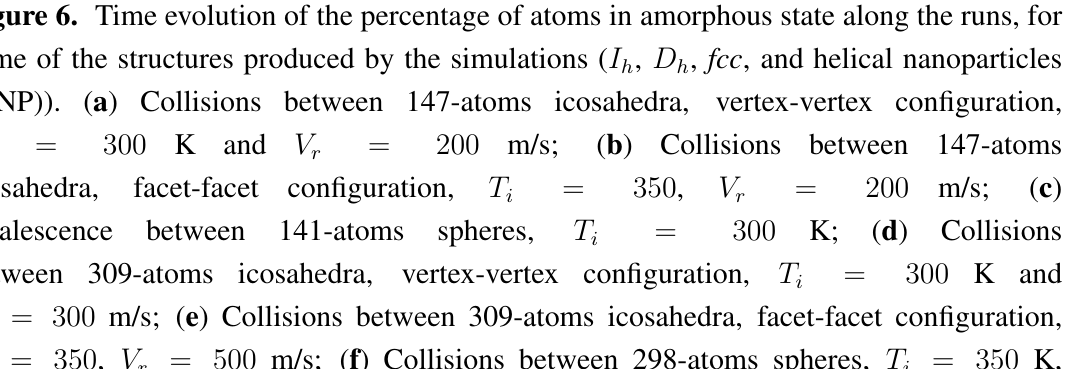
V = 300 m/s; ( e ) Collisions between 309-atoms icosahedra, facet-facet configuration, r T = 350 , V = 500 m/s; ( f ) Collisions between 298-atoms spheres, T i r V = 500 r